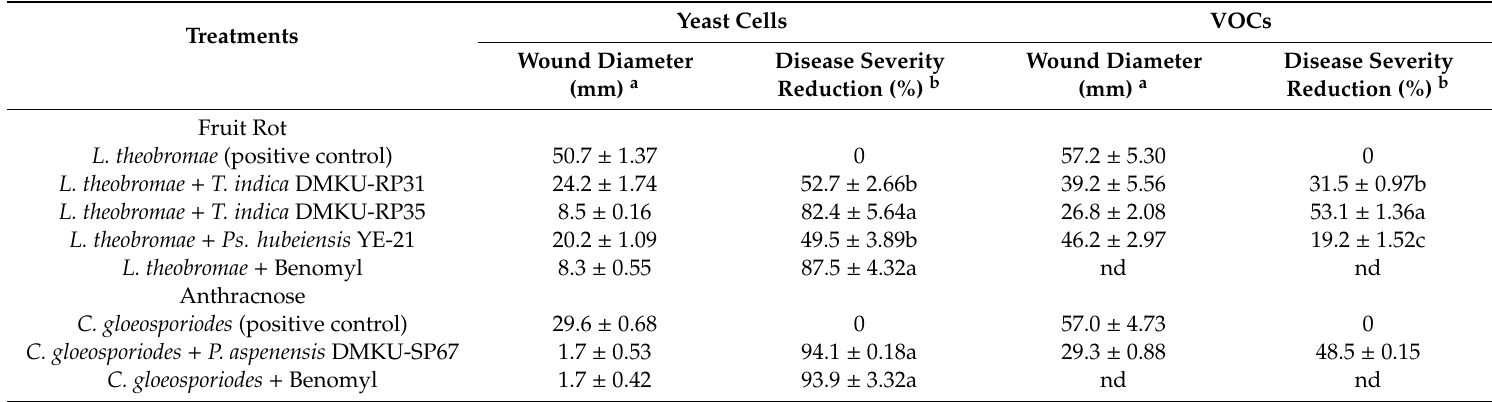
Table 3. Controlling of fruit rot (caused by L. theobromae ) and the anthracnose (caused by C. gloeosporiodes) by cell suspension of the antagonistic yeast strains and VOCs produced by the antagonistic yeast strains on postharvest mango fruits at 25 ◦ C for 7